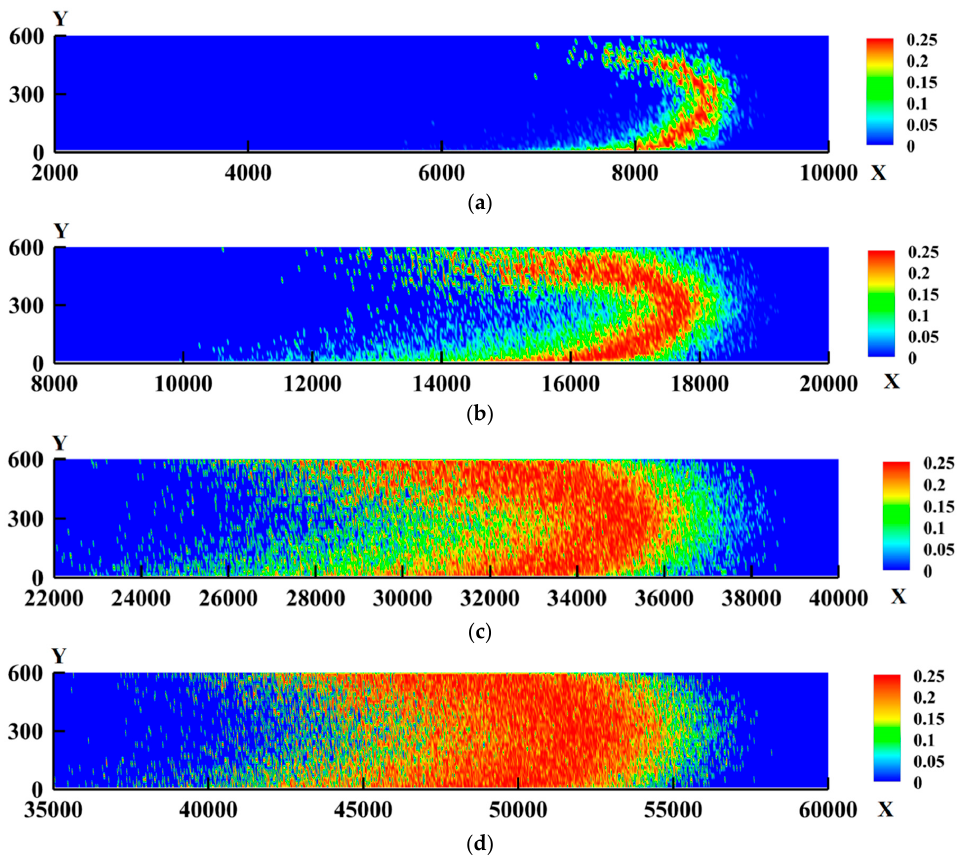
Figure 7. Mixing efficiency in the flow channel based on the contours of the mixing quality index, ϕ , for two puffs, puff A: Sc = 0.7, y o = 300, and puff B: Sc = 2400, y o = 15. ( a ) Contours of ϕ at t = 500; ( b ) at t = 1000; ( c ) at t = 2000; and ( d ) at t = 3000.